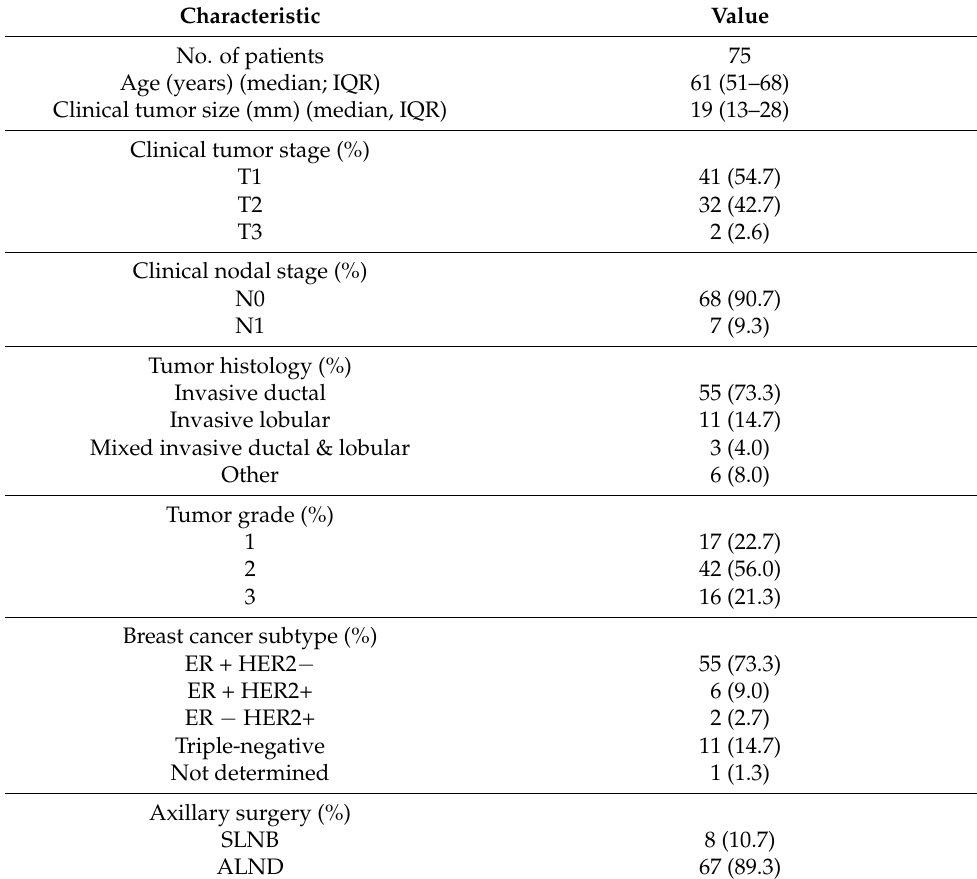
Table 1. Patient, tumor, and treatment